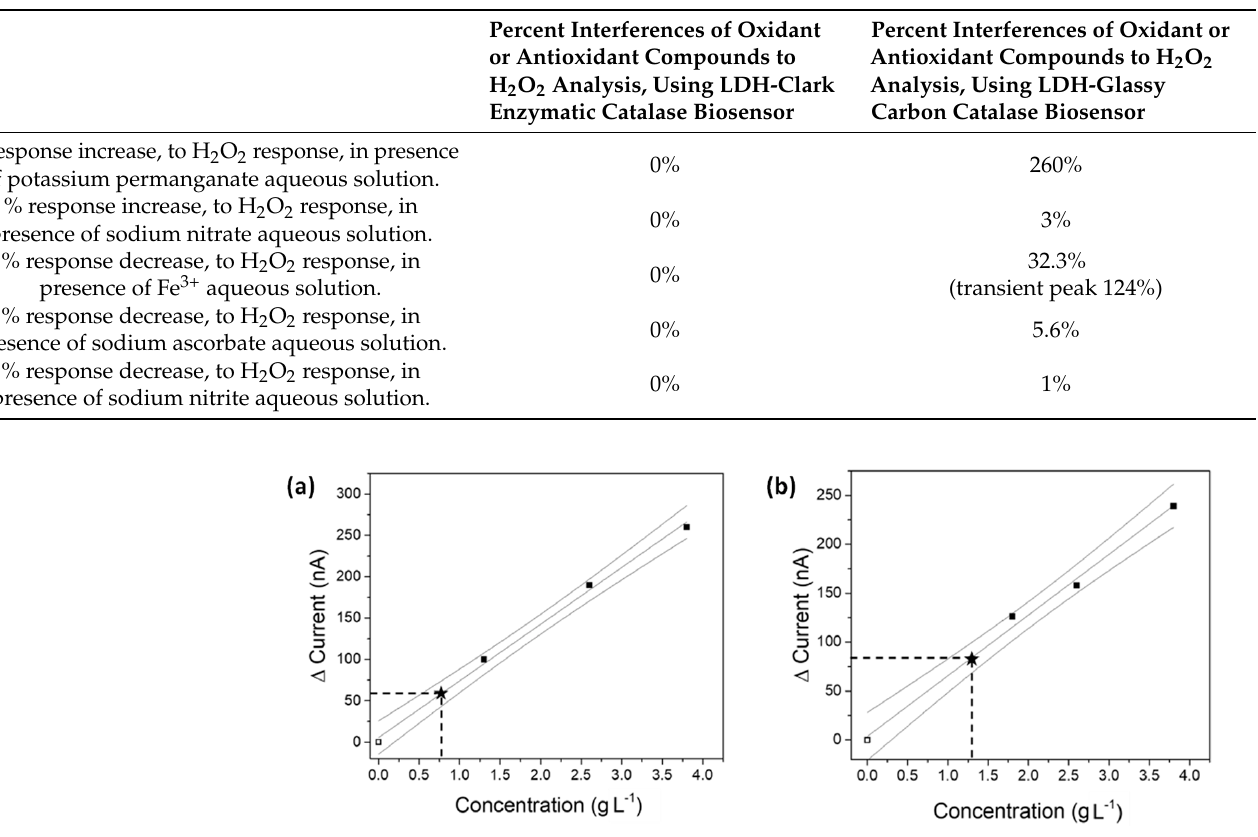
Table 3. Experimental percent recovery for hydrogen peroxide addition in cosmetic samples by Clark-type LDH-catalase enzyme biosensor. Sample Found Concentration in Cosmetic Sample (g L − 1 )